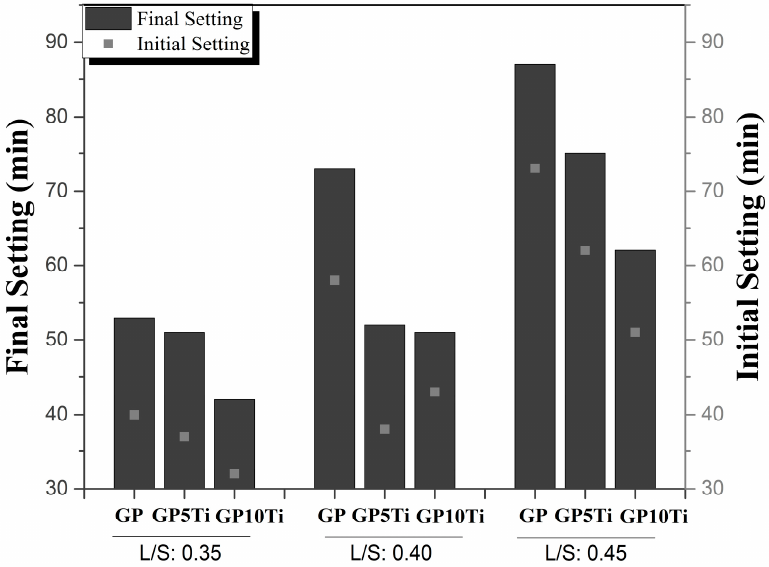
Figure 5. Setting times of the various materials evaluated.